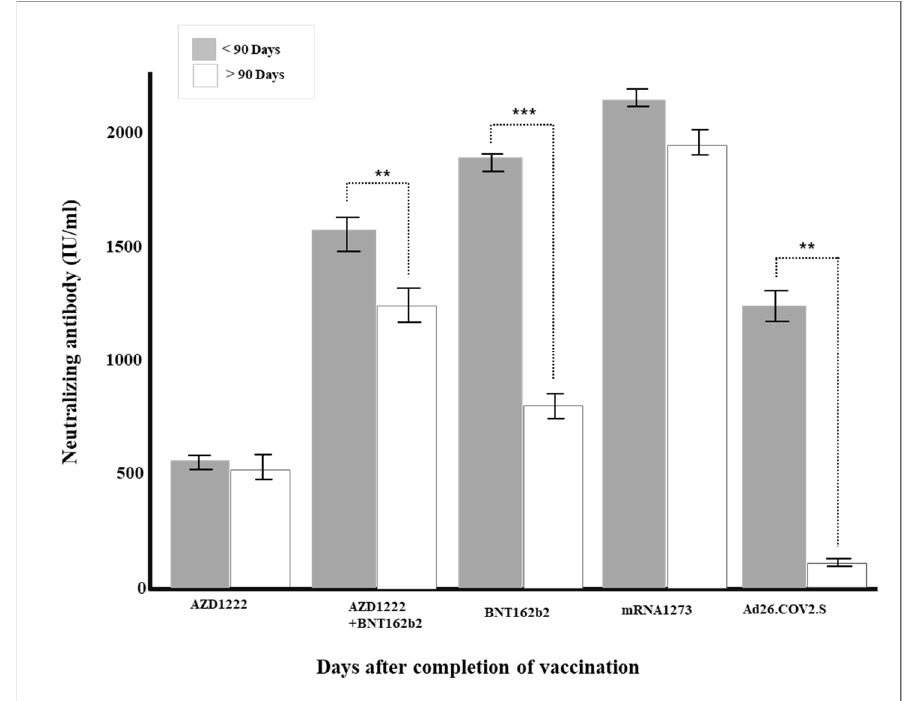
Figure 3. Changes in neutralizing antibody production according to the period after vaccination (** p < 0.01, *** p < 0.001).